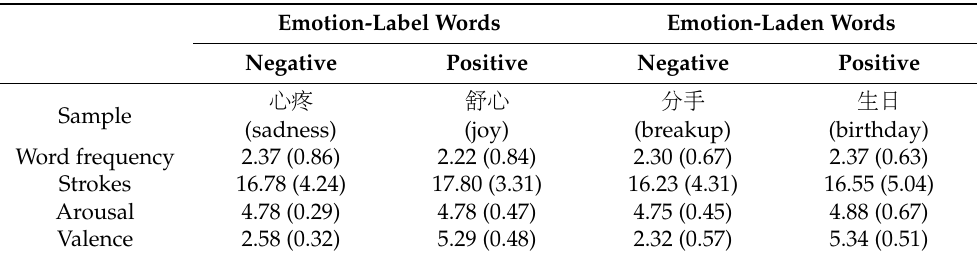
Table 1. Mean and standard deviation (SD) in brackets for word characteristics for Chinese emotion- label words and emotion-laden words as primes.